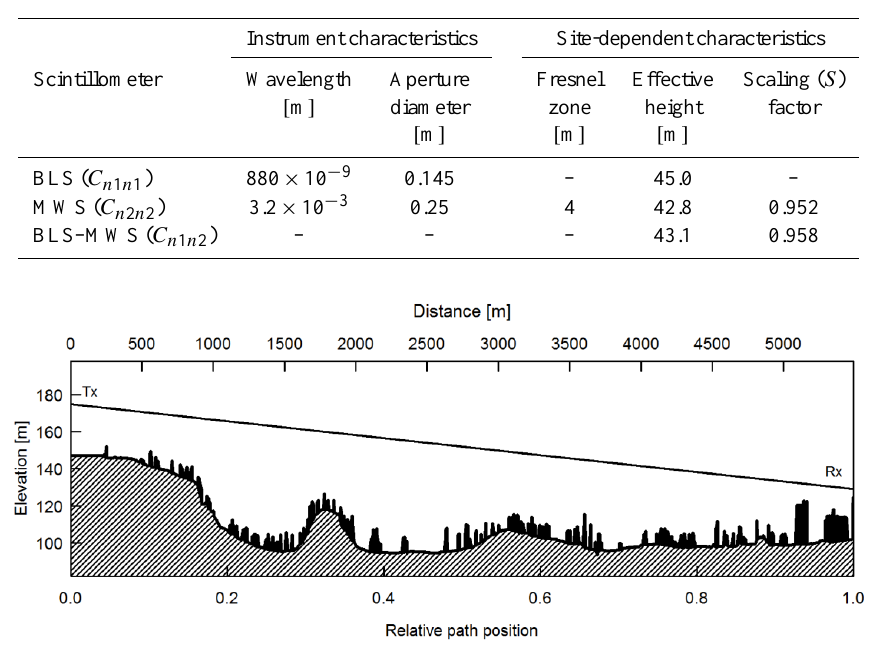
Table 2. Instrument and site-dependent characteristics of the scintillometers and paired scintillometer system.